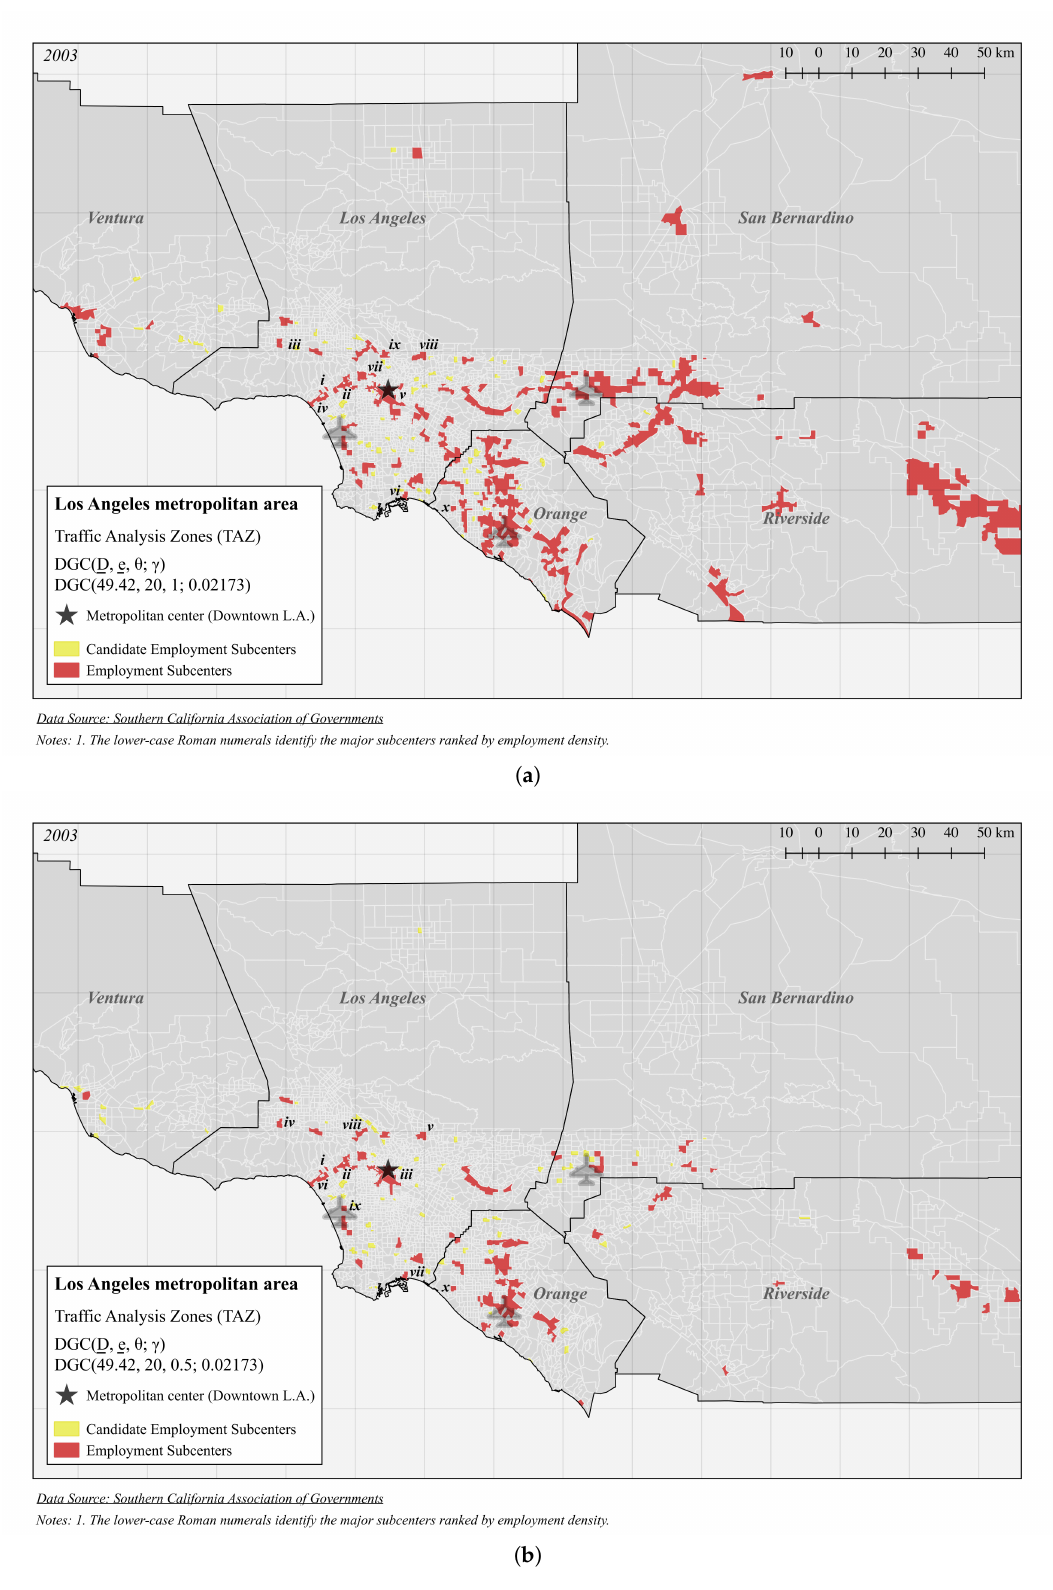
Figure 4. Los Angeles metropolitan area subcenters identified by: ( a ) DGC(49.42, 20, 1; 0.02173); ( b ) DGC(49.42, 20, 0.5;